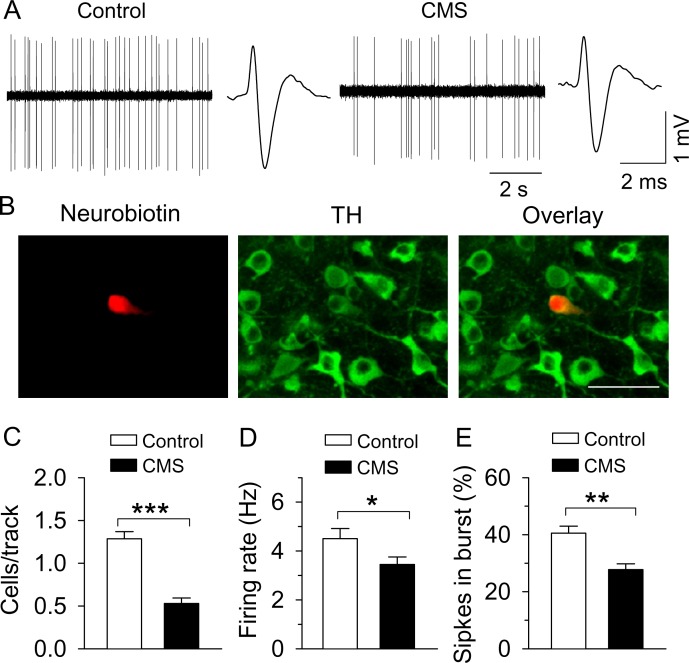
CMS decreased single-unit AP firing in VTA dopamine neurons in vivo.(A) Sample traces of VTA dopamine neuron AP firing in control and CMS mice. Dopamine neurons were identified by a broad triphasic extracellular action potential of a width greater than 2 ms and a relatively slow firing rate (<10 Hz). (B) A recorded dopamine neuron was confirmed by neurobiotin (red) and TH (tyrosine hydroxylase, green) co-localization. (C–E) Population activity (C, ***p<0.001, control, n = 4 mice; CMS n = 5 mice), firing rate (D) *p=0.045, control, n = 15 cells from four mice; CMS, n = 17 cells from five mice), and the percent of spikes in burst (E, **p=0.006, control, n = 10 cells from four mice; CMS, n = 13 cells from five mice) were decreased in CMS mice.10.7554/eLife.32420.006Figure 2—source data 1.In vivo VTA dopamine neuron firing following CMS in Figure 2C–E.